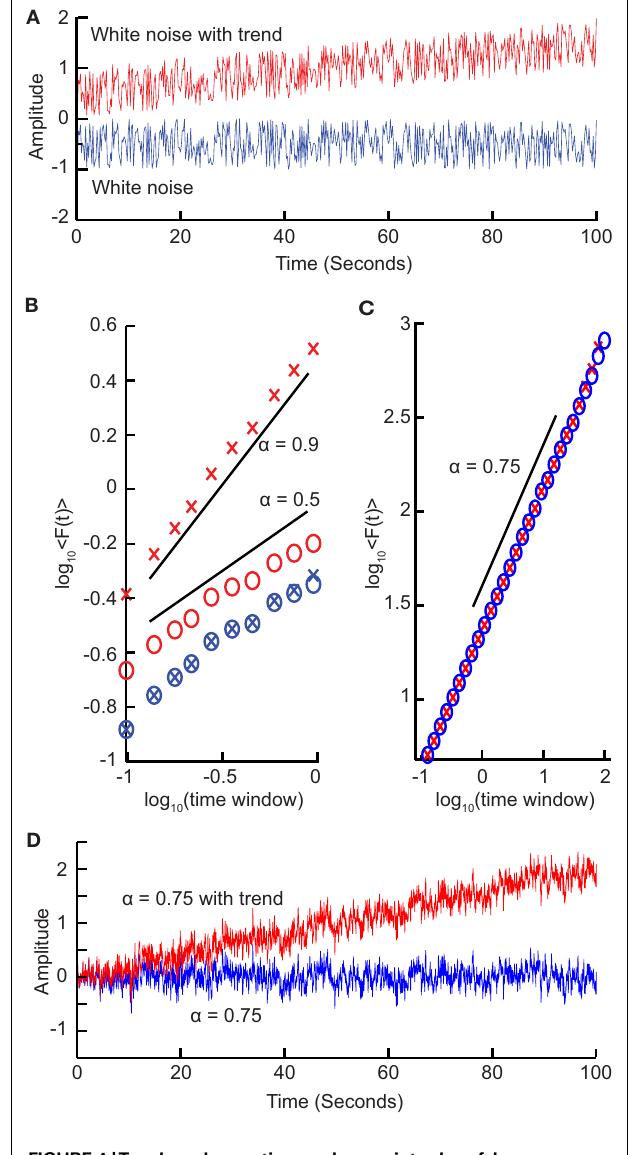
FIGURE 4 |Trends on longer time-scales can introduce false correlations into the signal. (A) For a signal with a trend, the standard deviation will be larger ( σ = 0.41) than the same signal with no trend ( σ = 0.29). (B) Average fluctuations for a window size shown for a white-noise signal ( blue crosses ) and the same signal with a trend added ( red crosses ) show different scaling. By removing the linear trend of the integrated signal from each window before calculating the standard deviation ( circles ), we recover the scaling seen without the long-time-scale trend. (C) Importantly, detrending self-similar signals with trends ( red crosses ) also recovers the scaling of the original signal ( blue circles ). (D) Self-similar signal ( α = 0.75) with trend ( red ) and without trend ( blue ) used in (C) .